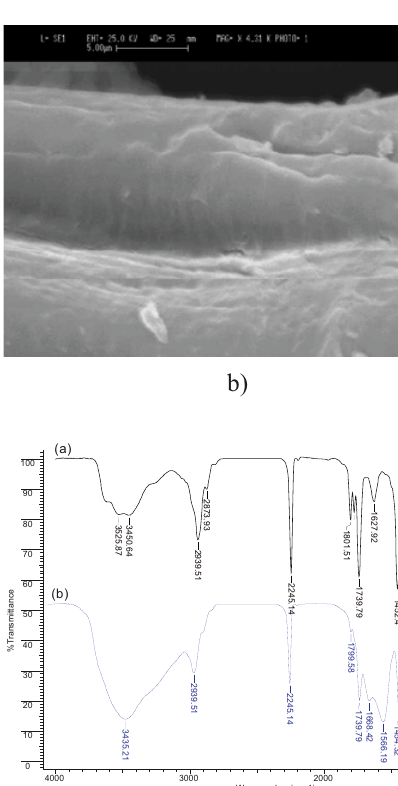
Figure 3. FTIR spectra of (a) PAN and (b) HPAN